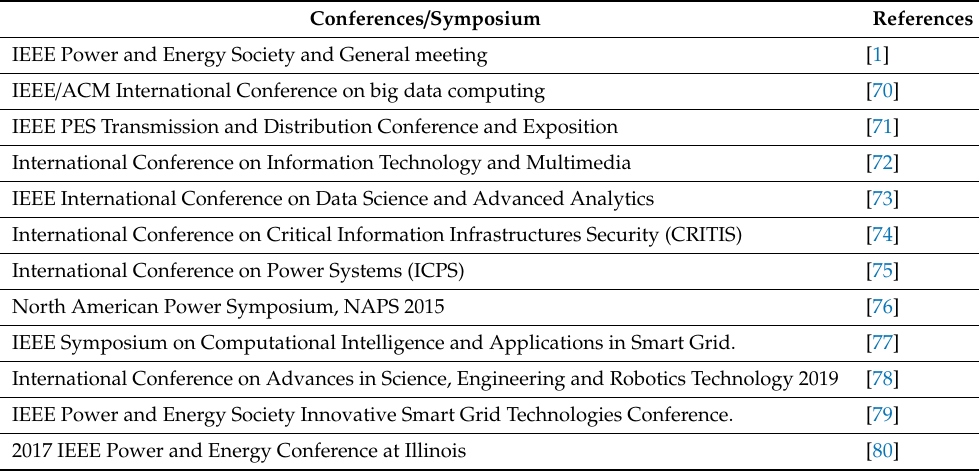
Table 2. Selected conferences in this